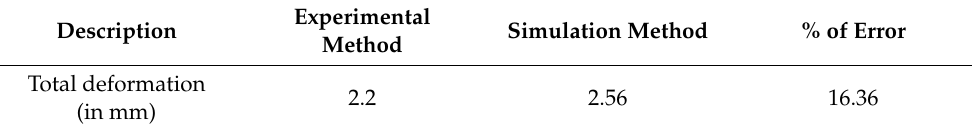
Table 12. Comparative study.